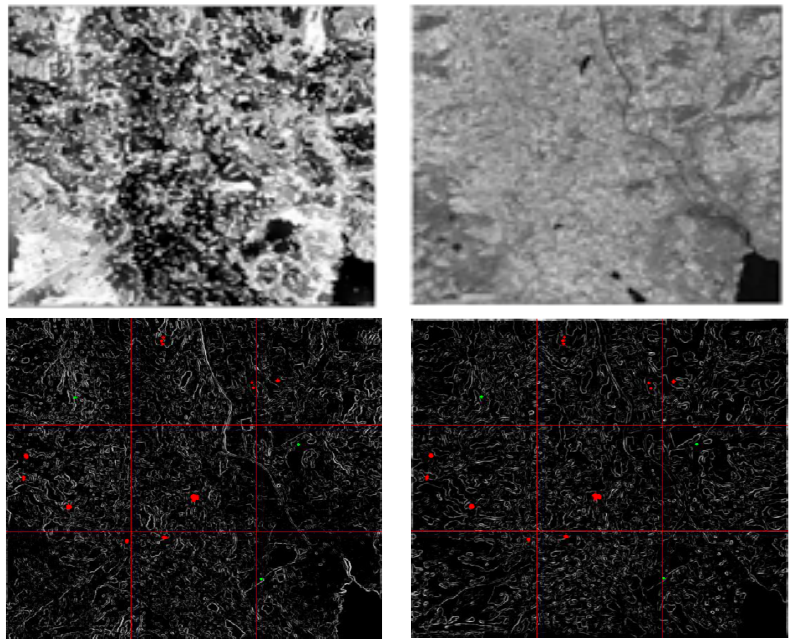
Figure 5. Radarsat-1 (left), Landsat-7/ETM+ (right), top grey level images, bottom thresholded gradient images used for matching to reduce grey level differences with 100 best match points (in red) and best point in 3x3 tiles with none of the 100 best points (in green).